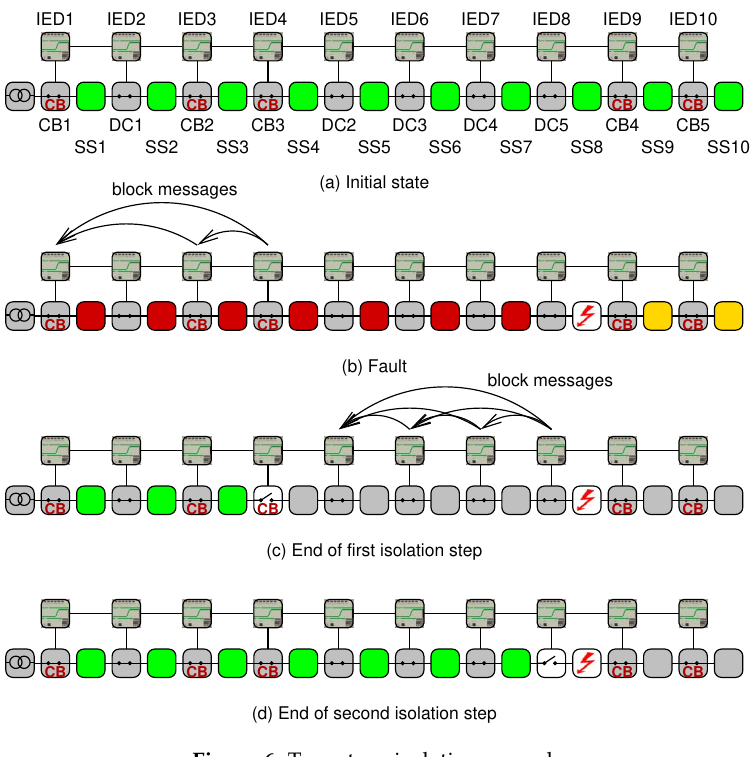
Figure 6. Two-steps isolation